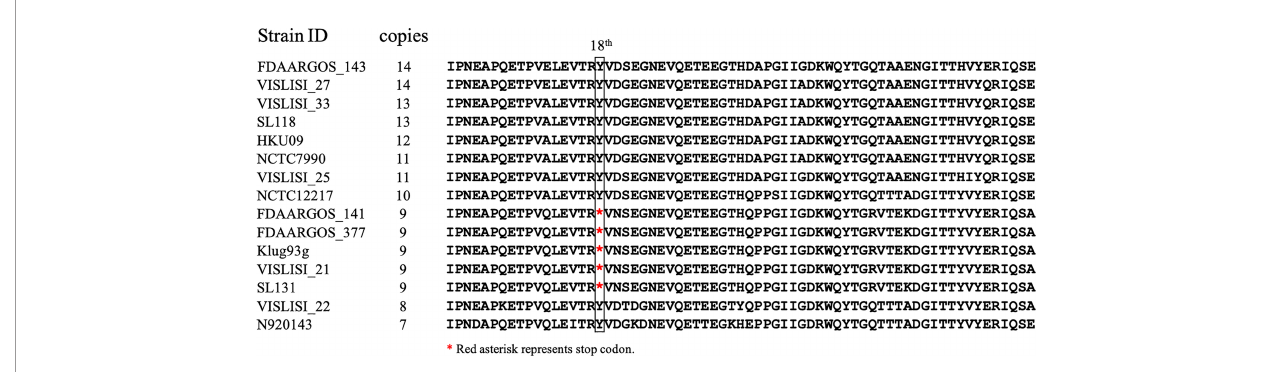
FIGURE 4 | Amino acid sequence comparison of the third repeat in different vWbl copies. vWbl third repeat amino acid sequence from 13 reference strains and two clinical isolates (CGMH-SL118 and CGMH-SL131) were compared as shown. The red asterisk represents the stop codon.